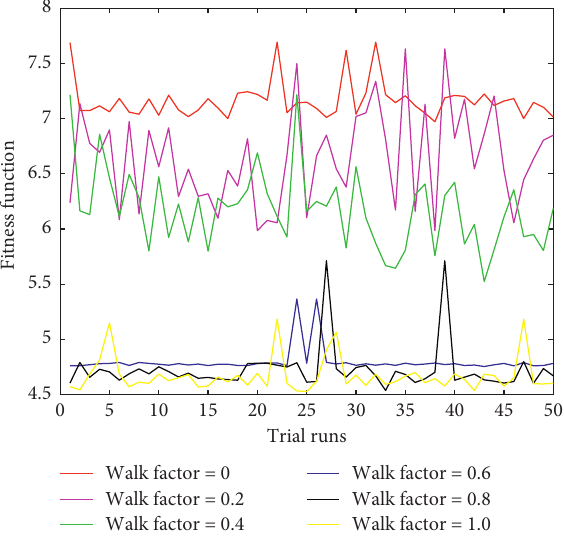
Figure 3: The impact of walk factor on obtained fitness values of 50 trial runs. Table 4: Comparisons for TPL of the IEEE 30-bus